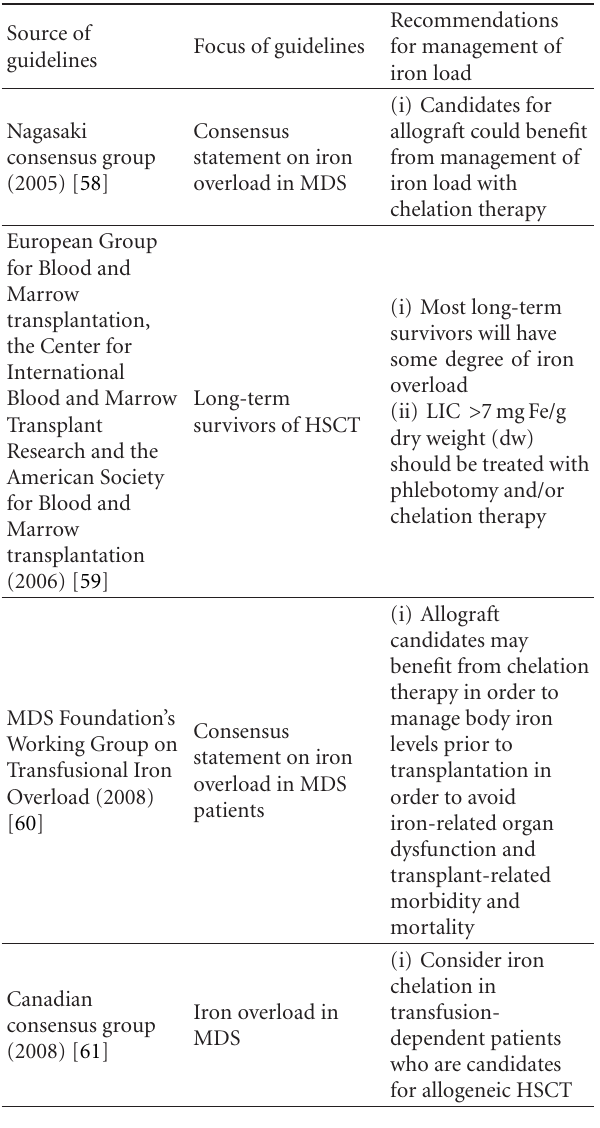
Table 3: Published guidelines for managing iron overload in HSCT